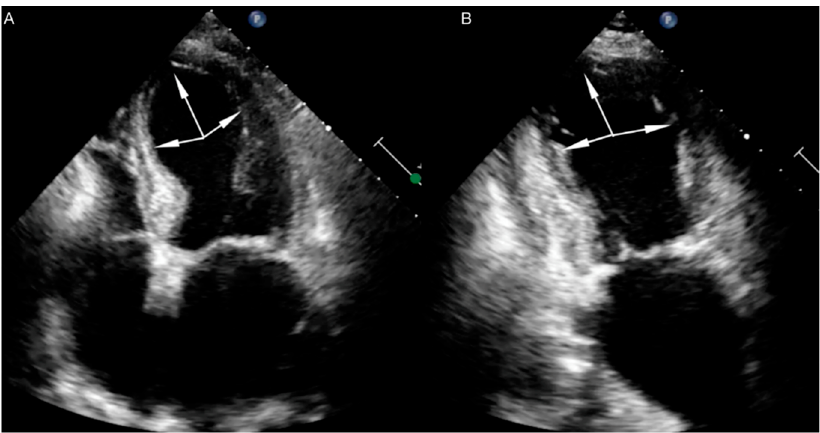
Figure 1. Echocardiography in a patient with typical (apical) form of TTS. ( A ) apical four chamber view. ( B ) apical two chamber view. The arrows show the region of contractility disturbance.